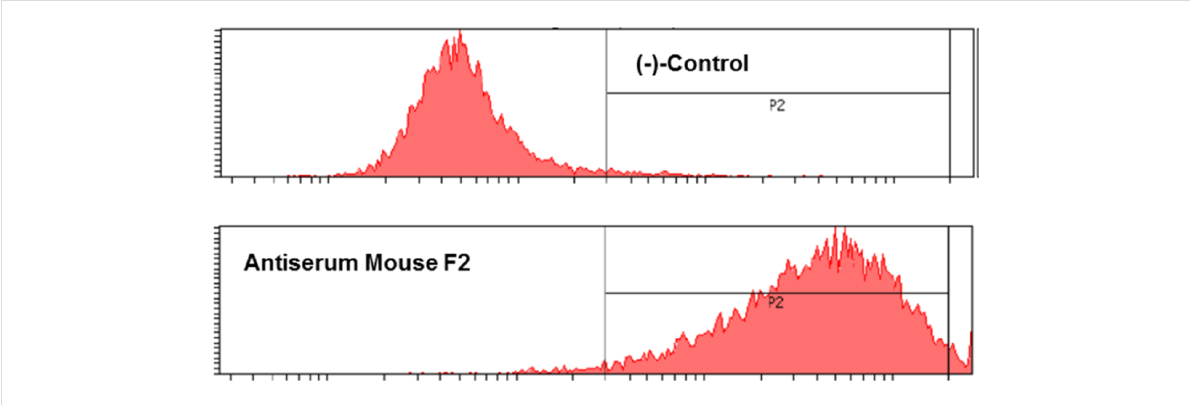
Figure 4: FACS analysis of the binding of MCF-7 tumor cells by the antiserum of mouse 2 induced by vaccination with 18b : cells treated with buffer solution (top); MCF-7 cells treated with antiserum of mouse 2 (bottom); fluorescence intensity (y-axis) vs counts of cells (x-axis).